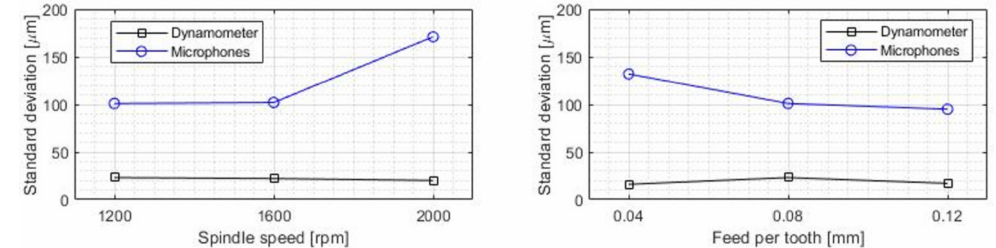
Figure 11. Mean standard deviation for each combination of machining